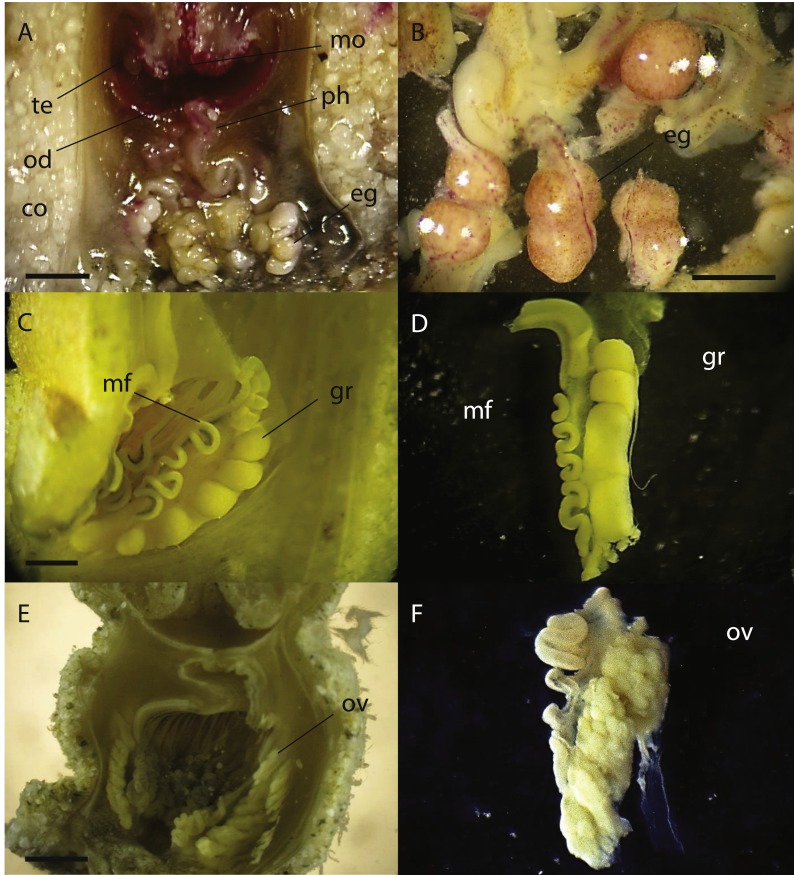
Cross sections of Palythoa sp. yoron and P. aff. mutuki showing ovary development.Cross section of polyp of (A) Palythoa sp. yoron (26 October 2010) and (B) matured eggs; (C) P. sp. yoron (9 November 2011) and (D) germinal ribbon inside a mesentery; (E) P. aff. mutuki (21 June 2011), and (F) developed ovaries. Abbreviations: te, tentacles; od, oral disk; co, coenenchyme; mo, mouth; ph, pharynx; eg, eggs; mf, mesenterial filament; gr, germinal ribbon; ov, ovary. Scale bars: 2 mm in (A) and (E) 500 µm in (B) 1 mm in (C, D and F) All images taken by M Mizuyama.